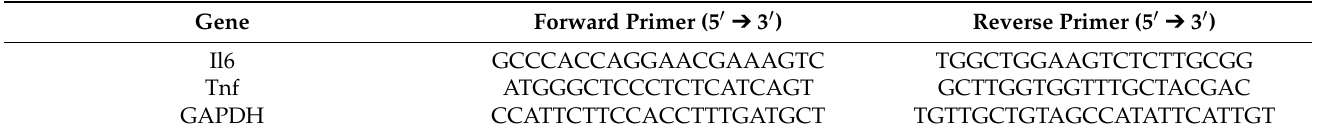
Table 3. Oligonucleotide sequence of primers used in